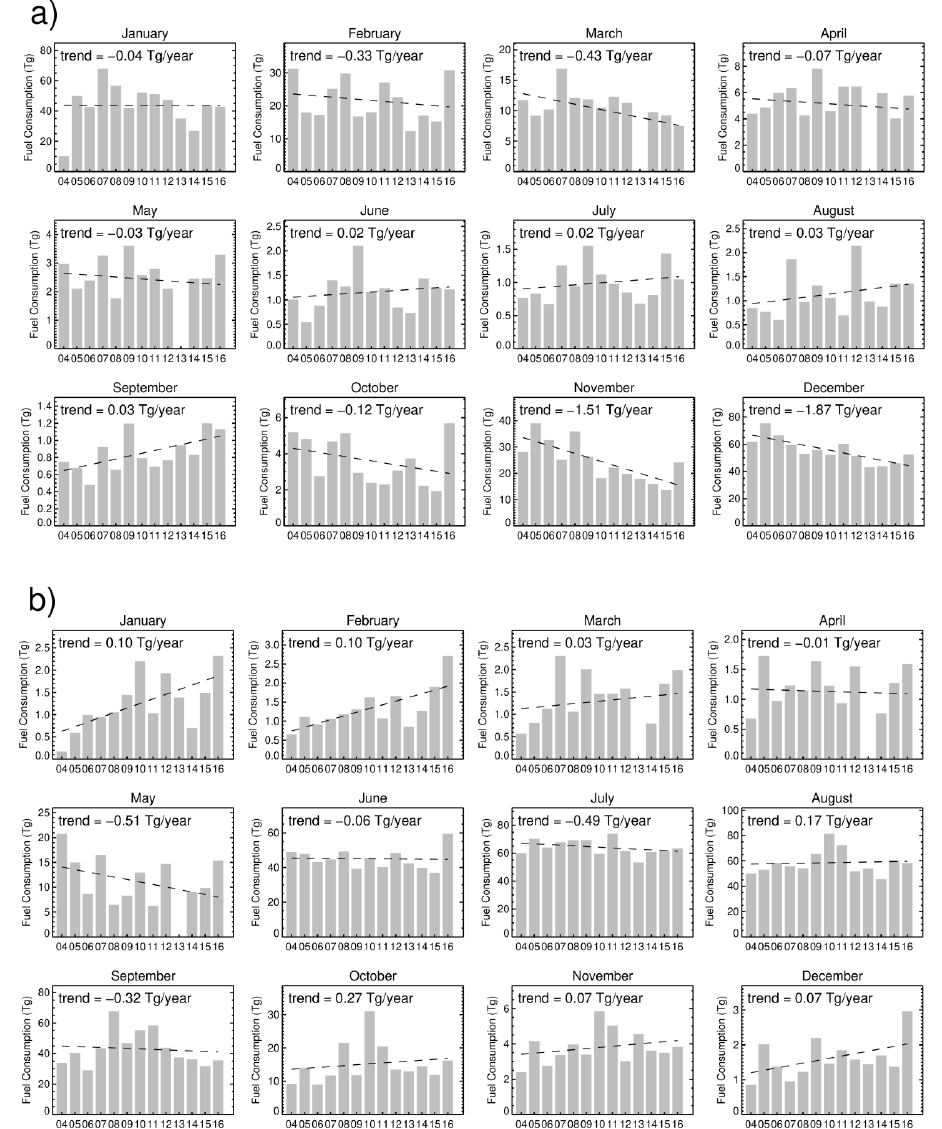
Figure 2. Monthly estimates of SEVIRI Fire Radiative Energy (FRE)-derived fuel consumption (Tg DM) over northern ( a ) and southern ( b ) hemisphere Africa between 2004 and 2012. A least-squares linear trend line is shown. Note that the y -axis range differs among plots.